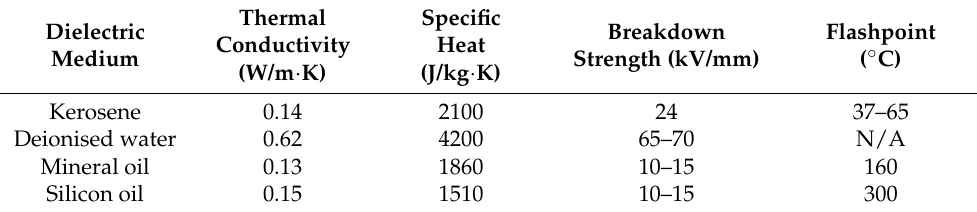
Table 2. Significant properties of dielectrics used in the PMEDM process